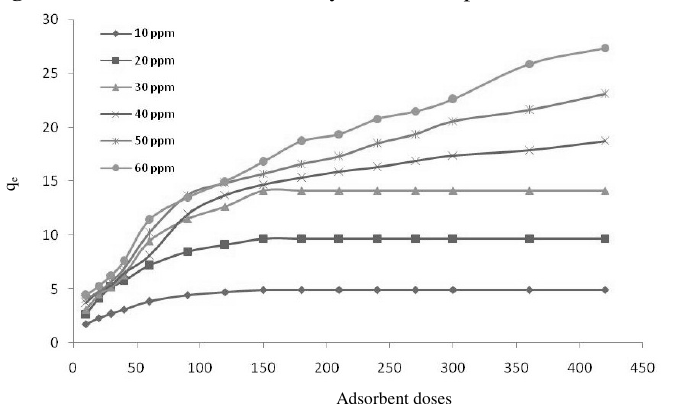
Figure 1. The removal of RHD dye with adsorption time at various initial time